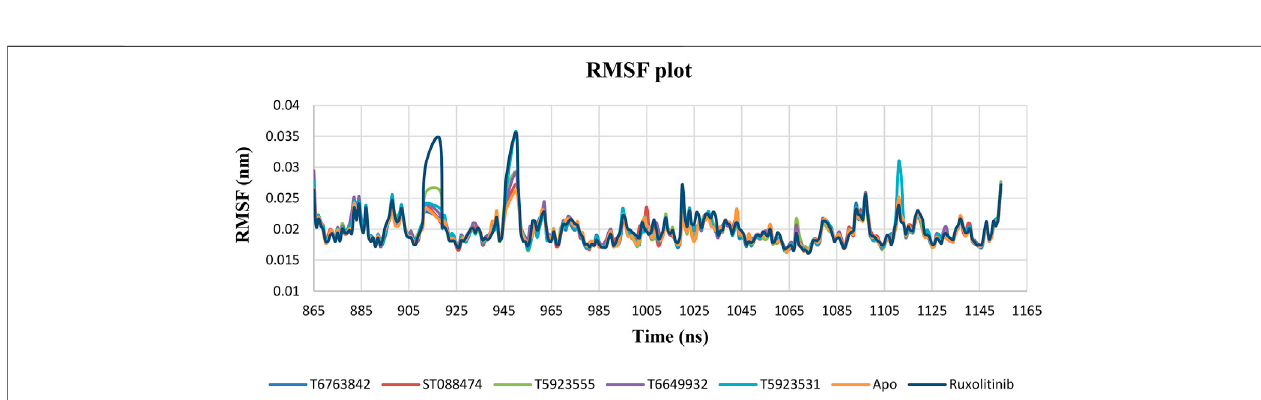
FIGURE 5 | The change in RMSD values of the backbone C α atoms of JAK1 systems over a period of 100 ns after binding with the lead compounds and drug.